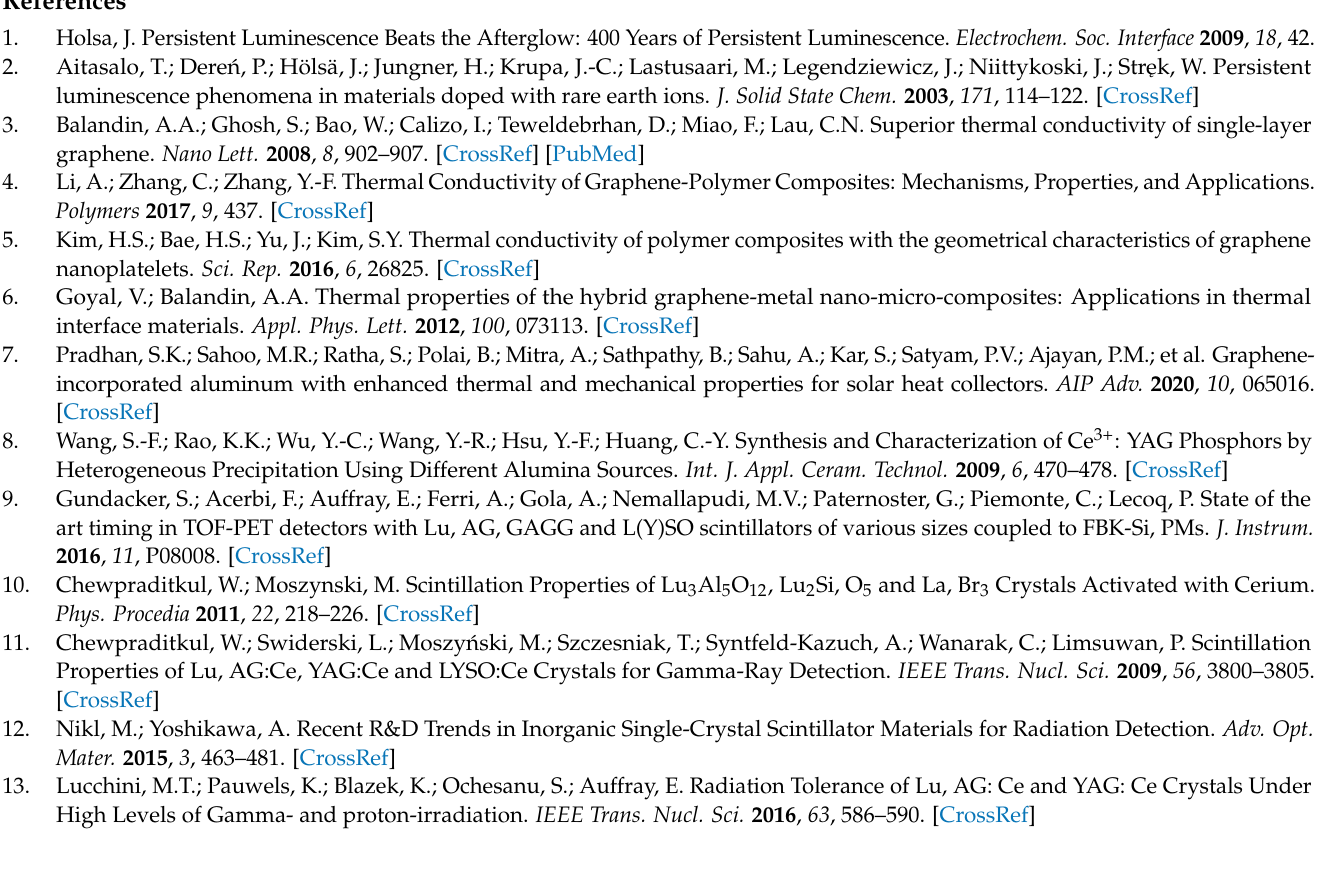
flakes; Figure S2: Raman spectrum of commercial single layer graphene flakes; Figure S3: TEM image of commercial single layer graphene